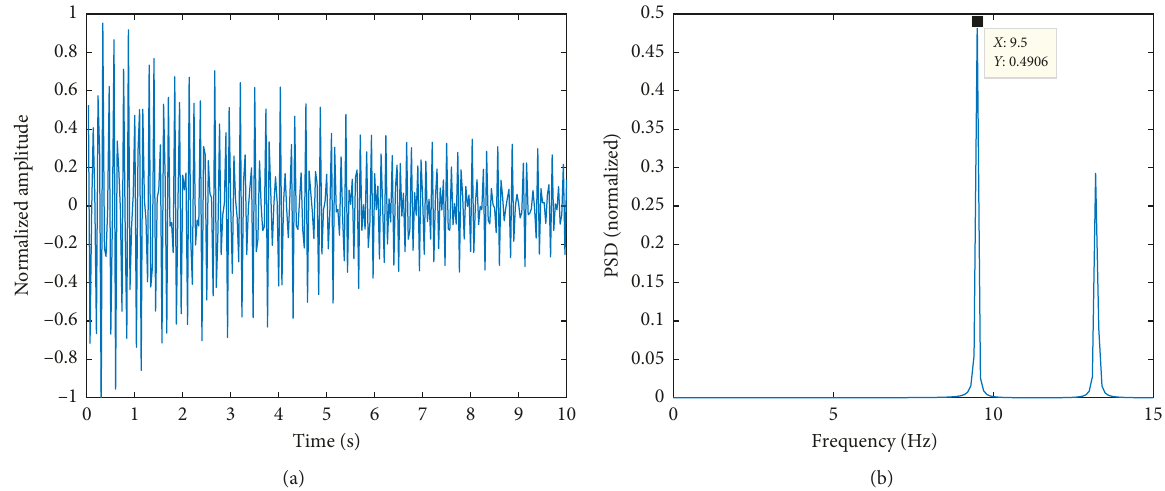
Figure 20: Cantilever steel beam experimental case 2 result from the vibrometer. (a) Normalized acceleration signal. (b) Normalized power spectral density.